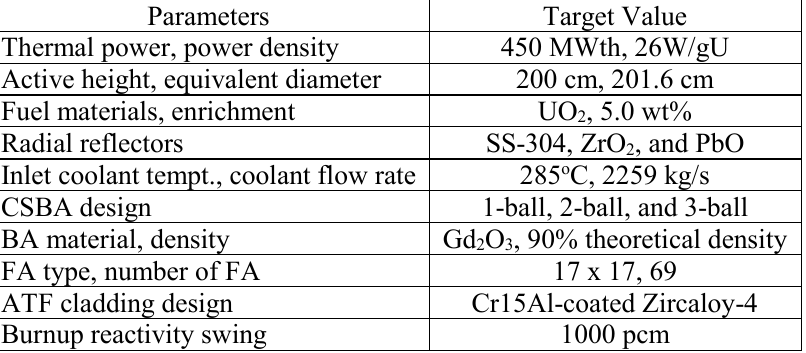
Table I: The Major Core Design